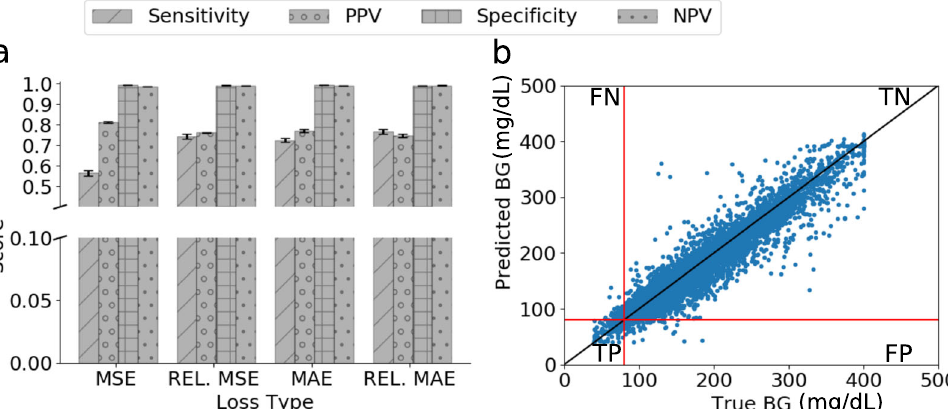
Fig. 5 Regression performance of the best CNN model on the original dataset (no augmentation on the training dataset), using four different loss functions. a Performance comparison between four loss functions, i.e., mean squared error (MSE), relative mean squared error (REL. MSE), mean absolute error (MAE) and relative mean absolute error (REL. MAE) in terms of four prediction scores, i.e., sensitivity, positive predictive value (PPV), speci fi city and negative predictive value (NPV). The results suggest that the relative mean absolute error (REL. MAE) serves as the best loss function in that it maintains good and balanced performance regarding the four scores shown. Hence, we keep the REL. MAE as the loss function for the subsequent analysis. Error bars (standard deviation, s.d.) are computed over all patients ’ results. b True blood glucose values measured by CGM vs. the predicted blood glucose values using REL. MAE as the loss function. The blue scatter points denotes the measurement-prediction pairs. The black diagonal line denotes the perfect prediction. The red lines denote the hypoglycemia threshold 80